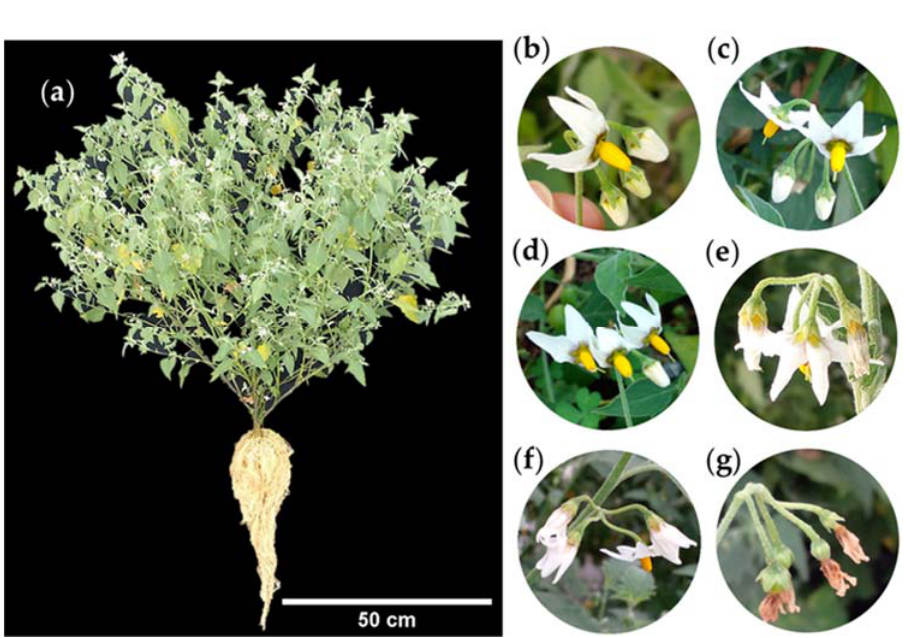
Figure 10. Flowering ( a ) of slender nightshade plants ( Solanum nigrescens ); inflorescence with 25 ( b ), 50 ( c ), and 75% ( d ) fertilized blossoms ( e ) developing fruit ( f ); and fruit set ( g ). Photos by Sara Monzerrat Ramírez-Olvera.